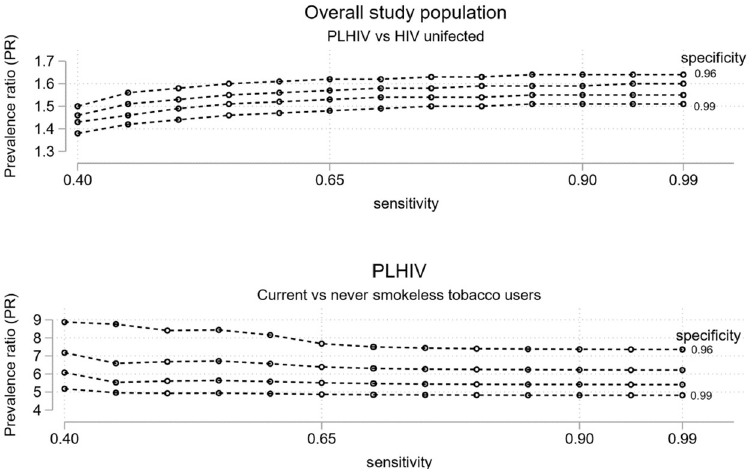
Fig 3. Corrected adjusted prevalence ratios for OPMDs under different plausible sensitivity and specificity parameters assuming non-differential misclassification of suspected OPMDs.